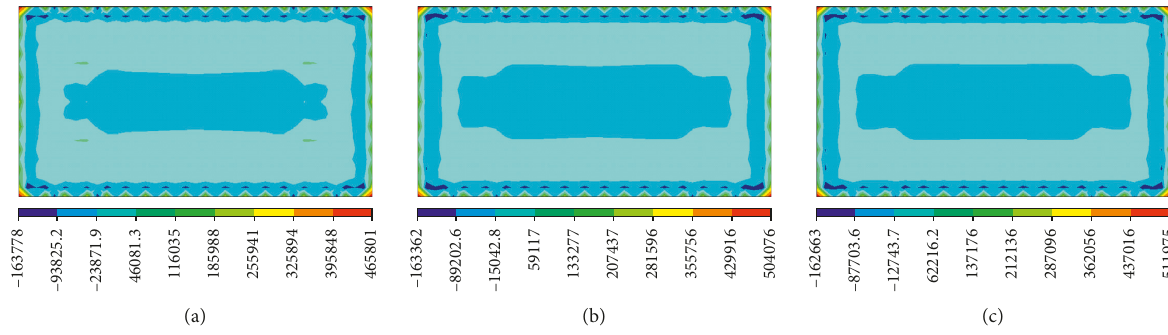
Figure 24: Normal stress of interface under condition 2. (a) P